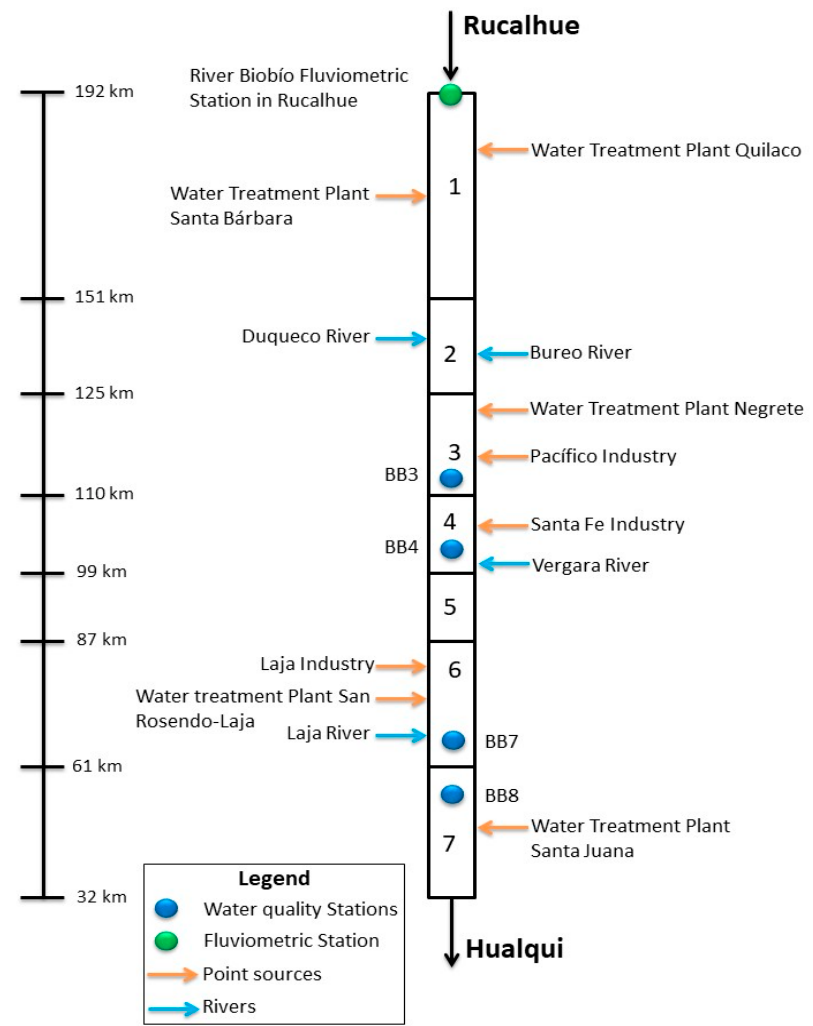
Figure 2. Conceptual diagram of the study of Biobío reach. The calibration and validation of the model were carried out with data from the monthly DO concentrations of the PMBB water quality stations. The calibration process was performed for March 2009, calibrating the parameters k a (Reaeration Coefficient), k d (Deoxygenation Coefficient), and the temperature correction coefficients θ a and θ d